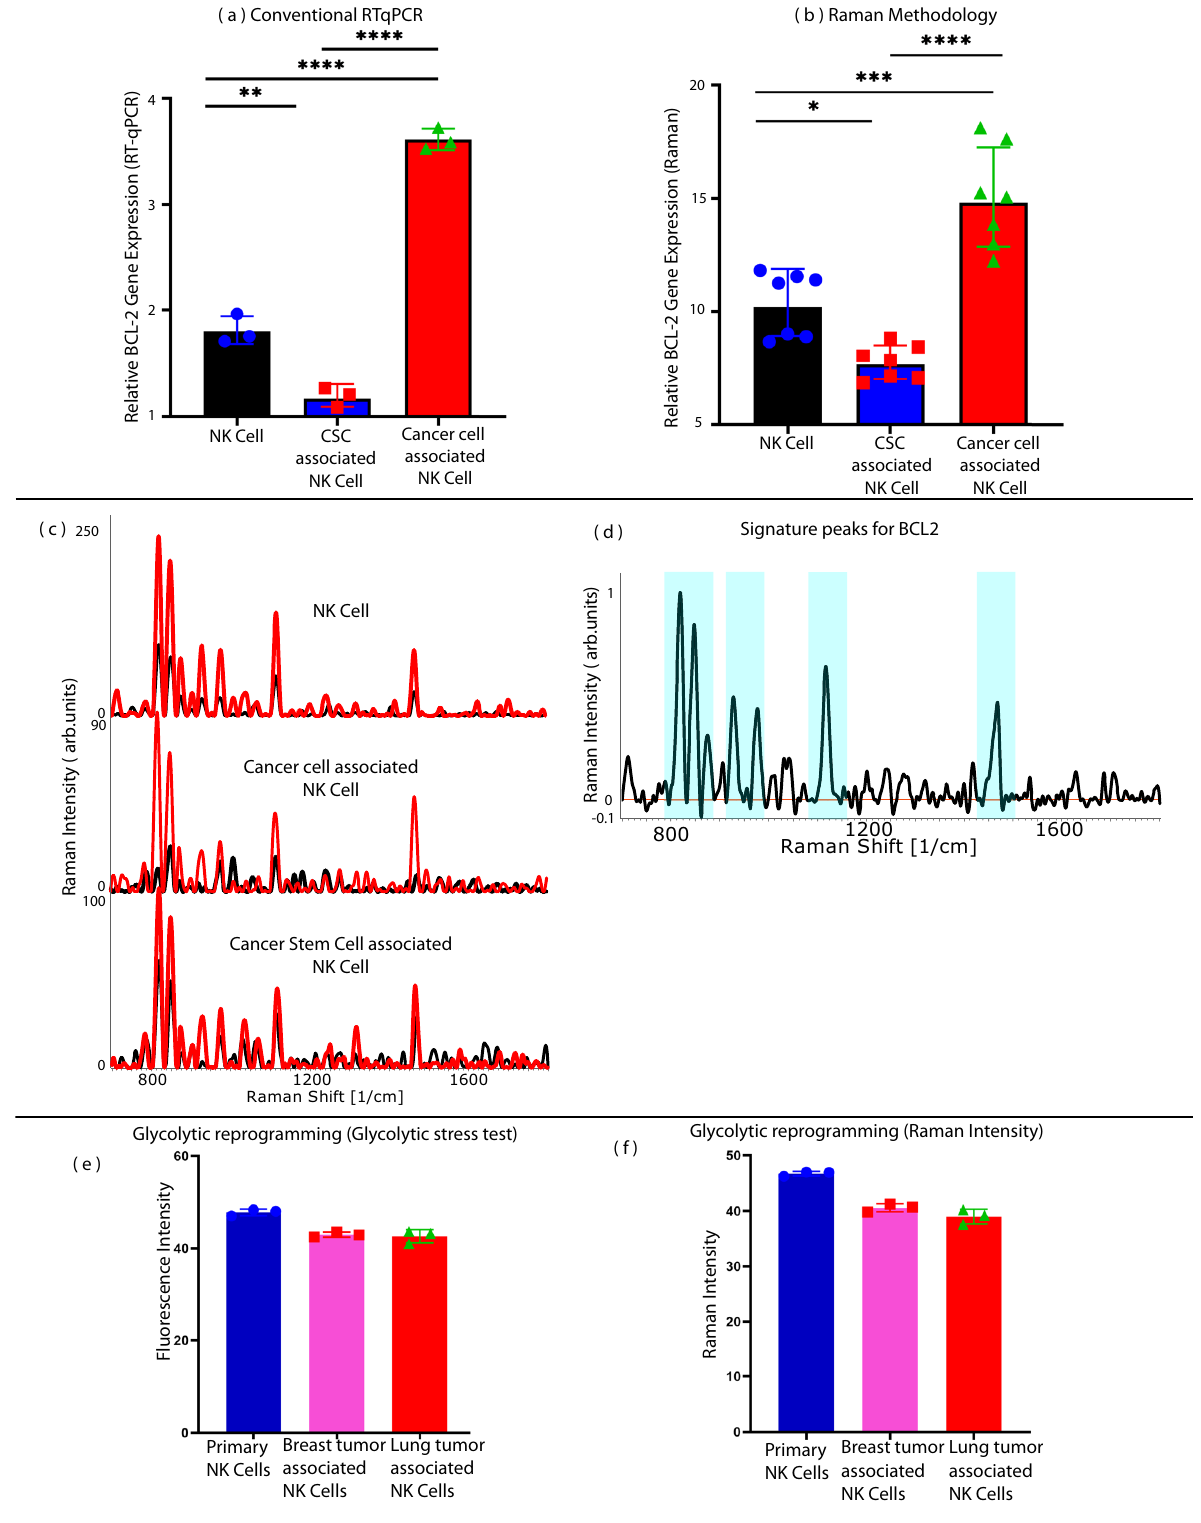
Fig. 10 | Validation of the differential SERS expression seen in cancer and CSC- associated NK cells and healthy NK cells using RT-qPCR and glycolysis stress test. a Conventional RT-qPCR results for quanti fi cation of BCL2, n =3 biologically independent experiments, analysis of variance (ANOVA) between cancer- associated NK cells, CSC-associated NK cells and control NK cells. b Detection of BCL2 expression with Raman methodology demonstrating similar trend with ANOVA between cancer-associated NK cells, CSC-associated NK cells and control NKcells(* P ≤ 0.05,** P ≤ 0.01,*** P ≤ 0.001,**** P ≤ 0.0001). c RamanspectraofBCL2